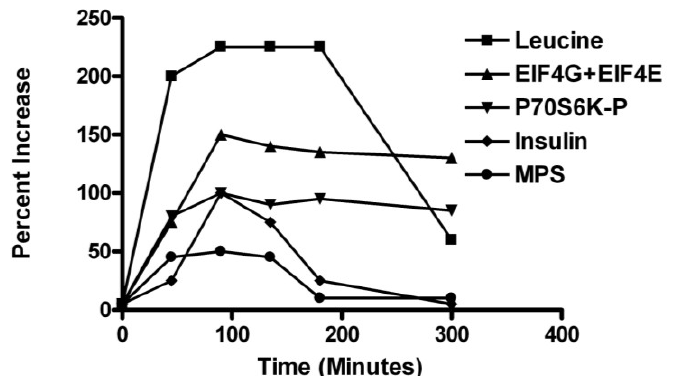
Figure 1. Time course changes in plasma leucine, translation initiation factor p70S6K (active form), Eukaryotic translation initiation factor 4E (active form), eIF4E, plasma insulin, and muscle protein synthesis in gastrocnemius muscle of rats fed a 4-g complete meal containing 20%, 50%, and 30% of energy from whey protein, carbohydrates, and fats, respectively